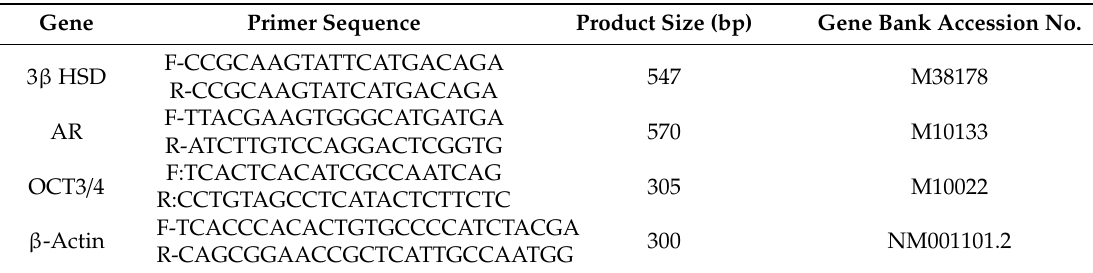
Table 2. Primers used for semi-quantitative RT-PCR.